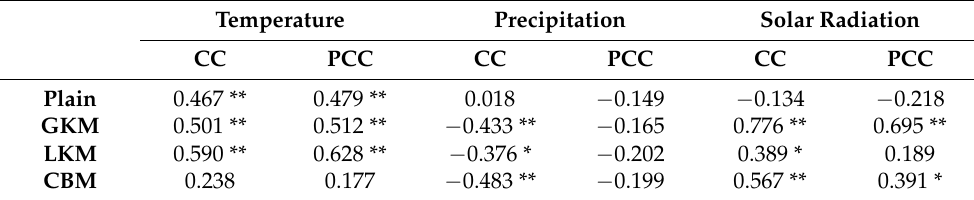
Table 1. Correlation coefficient (CC) and Partial correlation coefficient (PCC) between regional accumulated GPP (GPP GS ) and meteorological factors (daily average temperature, precipitation and daily solar radiation) in different regions (Plain, GKM refers to the Greater Khingan Mountain, LKM refers to the Lesser Khingan Mountain, and the CBM refers to the ChangBai